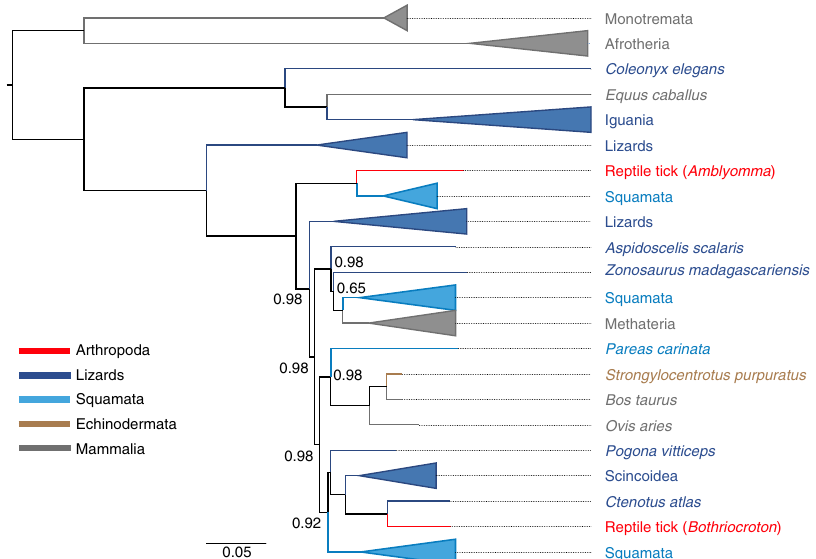
Fig. 3 Evidence for ectoparasite-mediated horizontal transfer of BovB LINEs in squamate reptile genomes. A summarized Bayesian phylogenetic tree of full-length BovB LINE sequences for 87 metazoan species, including two reptile ticks. Branches have been collapsed and colored to represent major clades. Posterior probabilities are shown only at nodes that had posterior support